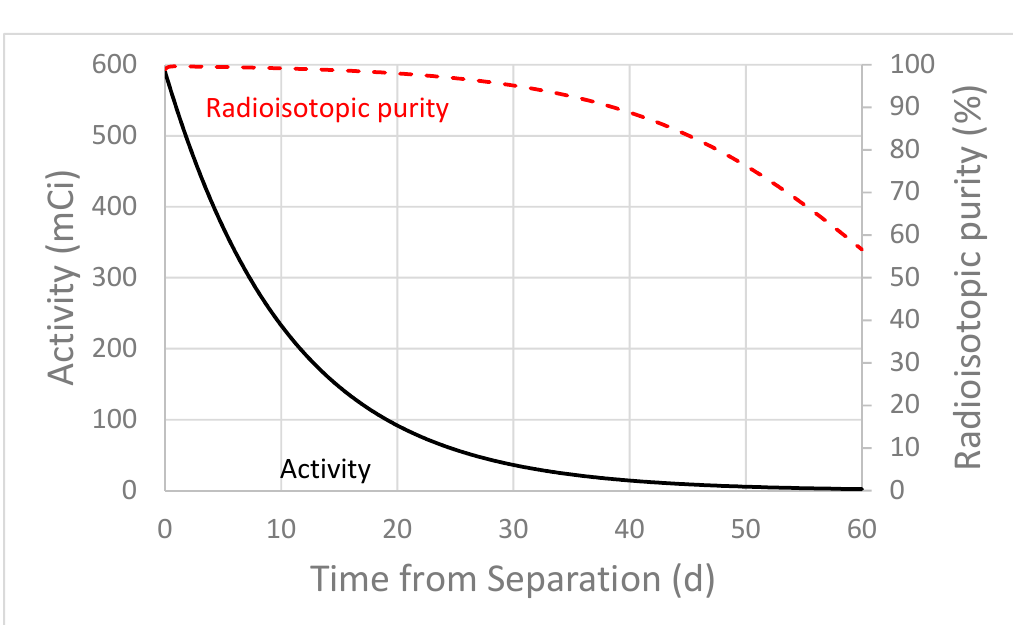
Figure 2. Radioisotopic purity of Ac-225 as a function of time from final chemical purification. The four curves depict the various durations between the EOB and the final purification. These values represent the radioisotopic purity of Ac-225, only considering all actinium isotopes (radioisotopic purity from Figure 1).